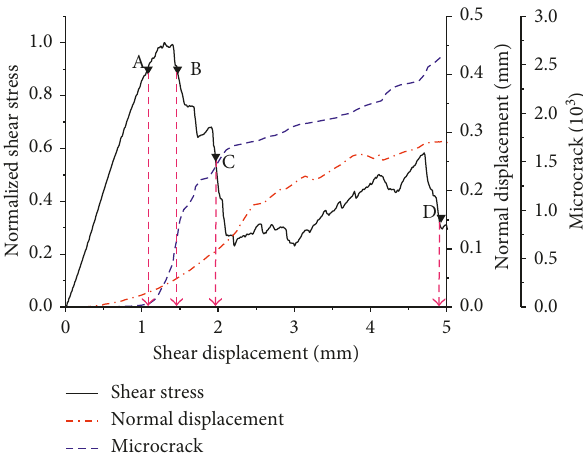
Figure 9: Shear curves of Sample